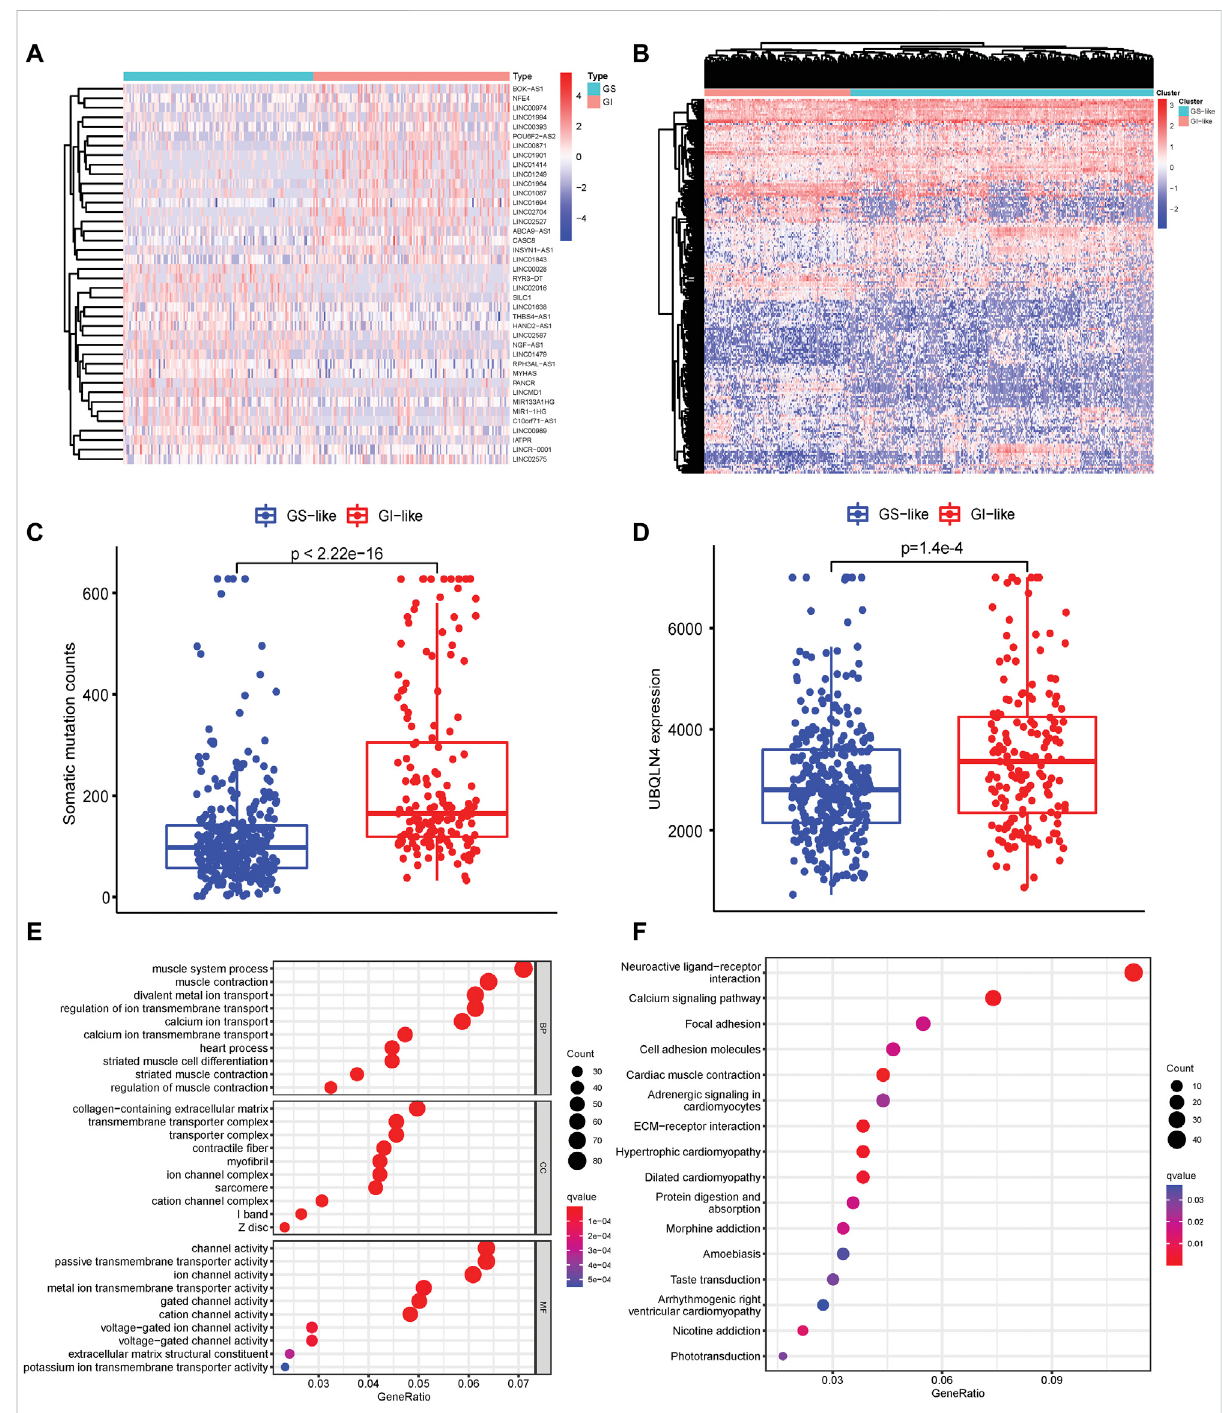
FIGURE 1 Identi fi cationofgenomicinstability-relatedlncRNAsinHNSCC. (A) Heatmappfexpressionofthetop 20differentiallyexpressedlncRNAsinGI- like and GS-like groups. (B) Unsupervised clustering of 499 HNSCC patients based on the expression patterns of 199 genomic instability-related lncRNAs. (C) SomaticmutationcountsintheGI-likeandGS-likegroups. (D) UBQLN4expressionlevelintheGI-likeandGS-likegroups. (E) GOterms analysis of the differentially expressed lncRNA-related gene coding mRNAs. (F) KEGG pathway analysis of the differentially expressed lncRNA- related gene coding